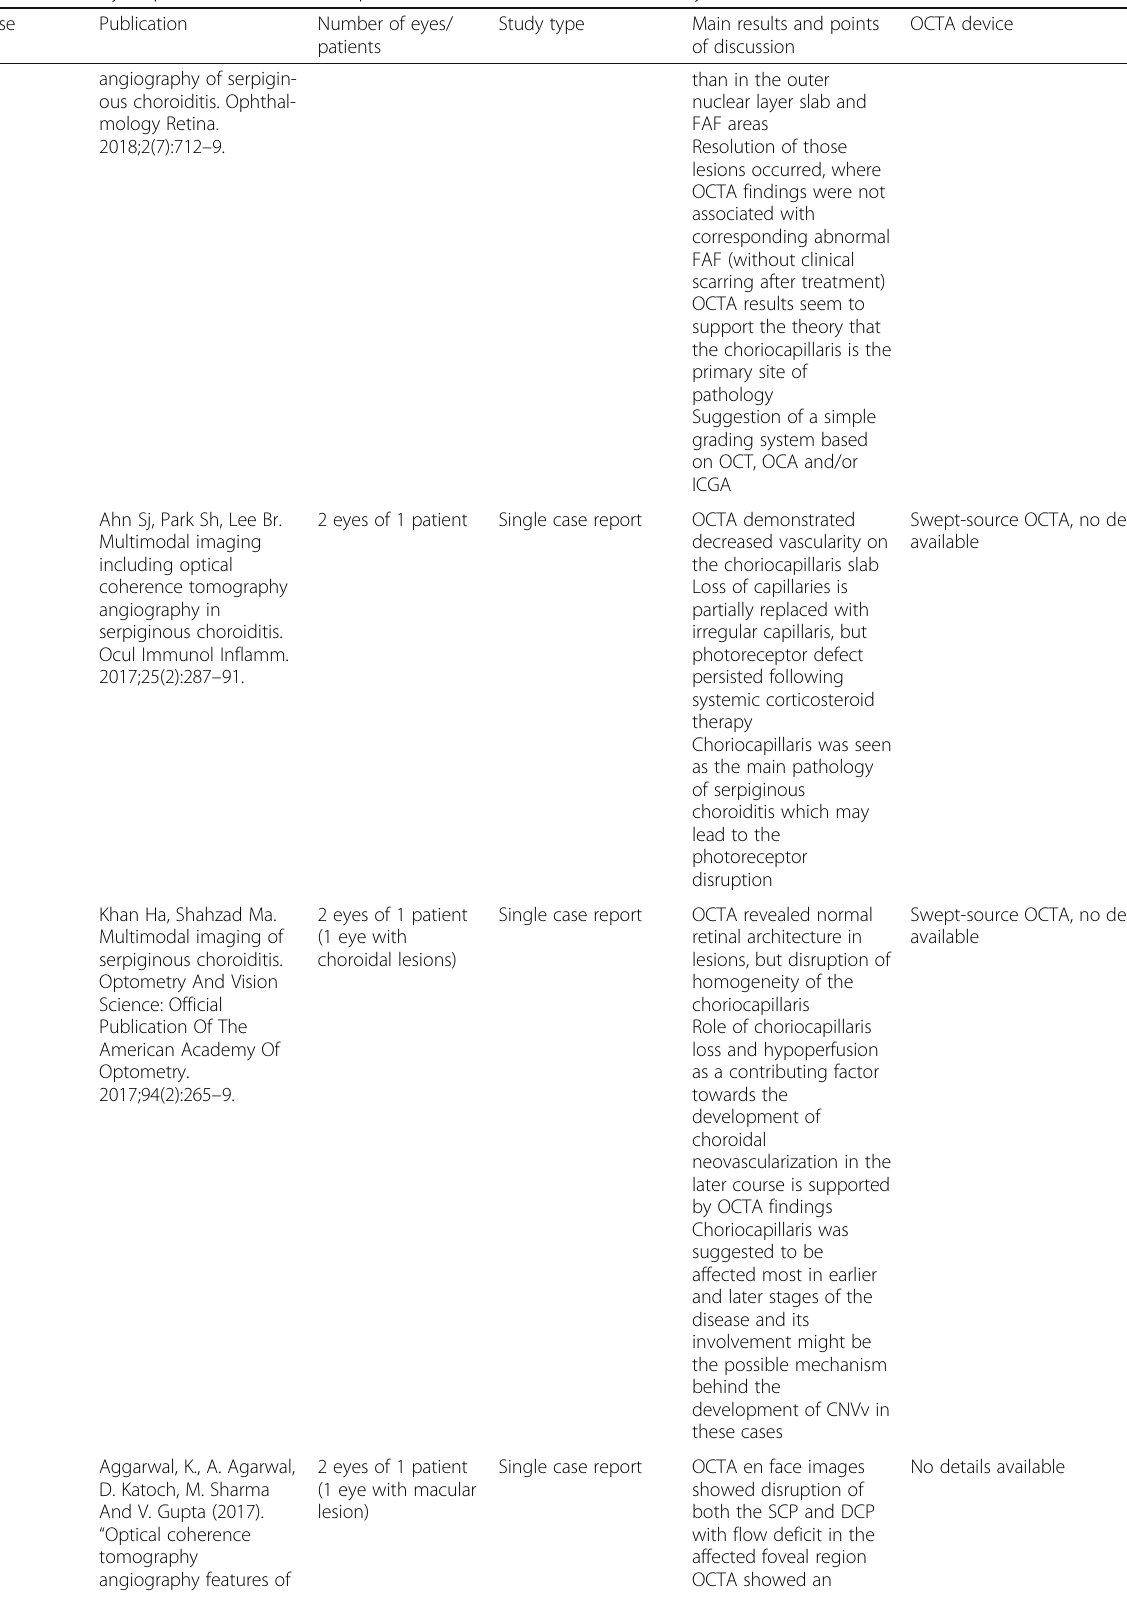
Table 1 Summary of publications on the implementation of OCTA in white dot syndromes (Continued)